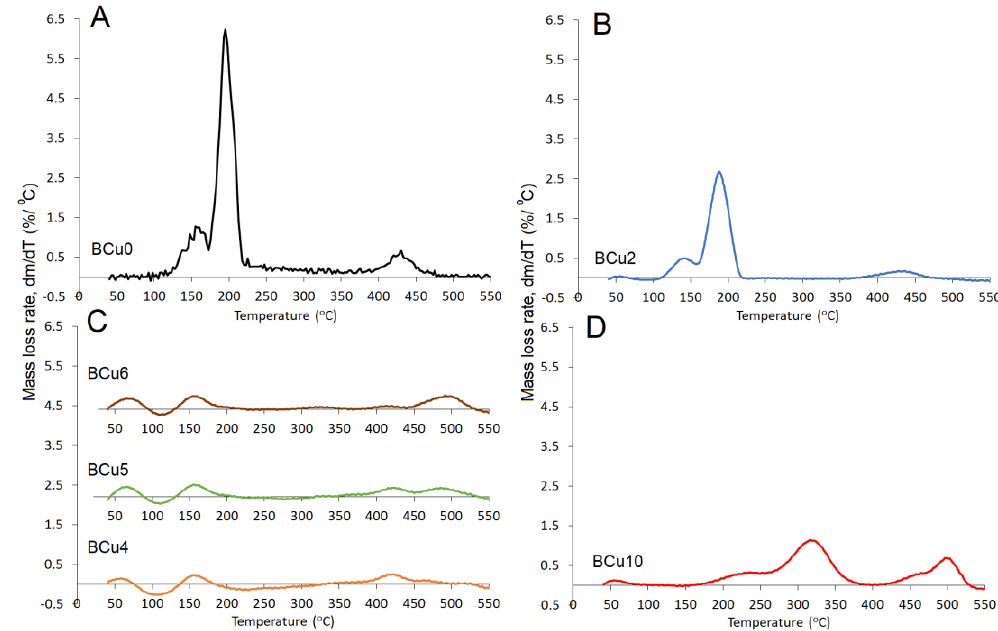
Figure 7. Differential thermogravimetric analysis (TGA) of Ca-Cu phosphates, ( A ) BCu0, ( B ) BCu2, ( C ) BCu4, BCu5, and BCu6, and ( D ) BCu10 compounds.